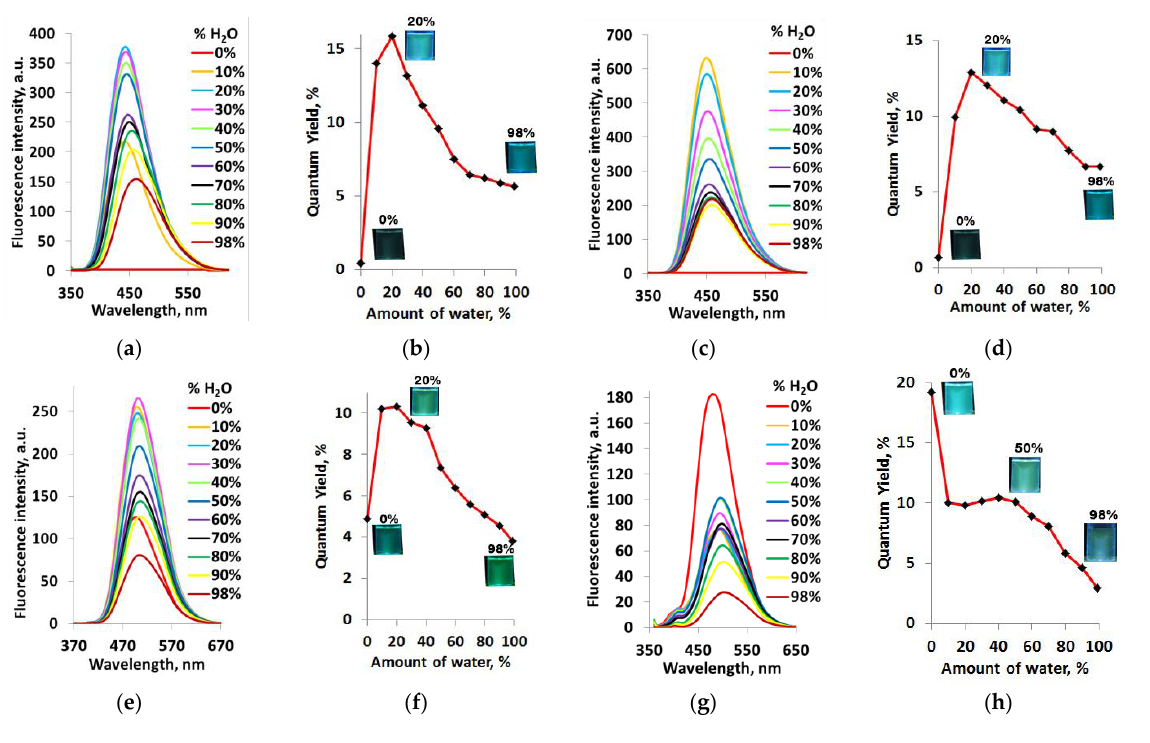
Figure 7. ( a , c , e , g ) Fluorescence spectra of DATs ( a , c ) 10 and ( e , g ) 11c (c = 1 × 10 − 5 M) in the ( a , e ) DMSO–H 2 O and ( c , g ) THF–H 2 O mixtures with gradually changing water content. ( b , d , f , h ) Plot of the emission intensity (QY) of DATs ( b , d ) 10 and ( f , h ) 11c versus a water fraction from 0 to 100% in ( b , f ) a DMSO–H 2 O and ( d , h ) a THF–H 2 O mixture. Inserts: photographs of DATs–NMe 2 10 and 11c solutions in DMSO–H 2 O and THF–H 2 O mixtures ( v / v , 1:9).